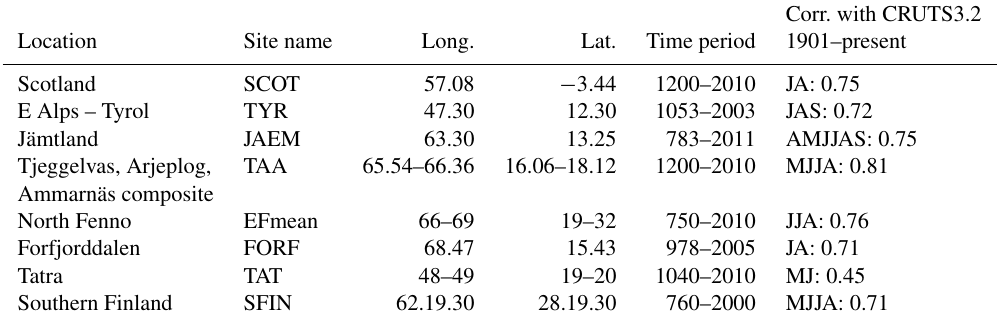
Table 1. Tree-ring sites used to constrain summer reconstructions of 1241–1970, with correlations with observed mean temperature from Wilson et al. (2016) for the indicated months. JA: July–August; JAS: July–September; AMJJAS: April–September; MJJA: May–August; JJA: June–August; MJ: